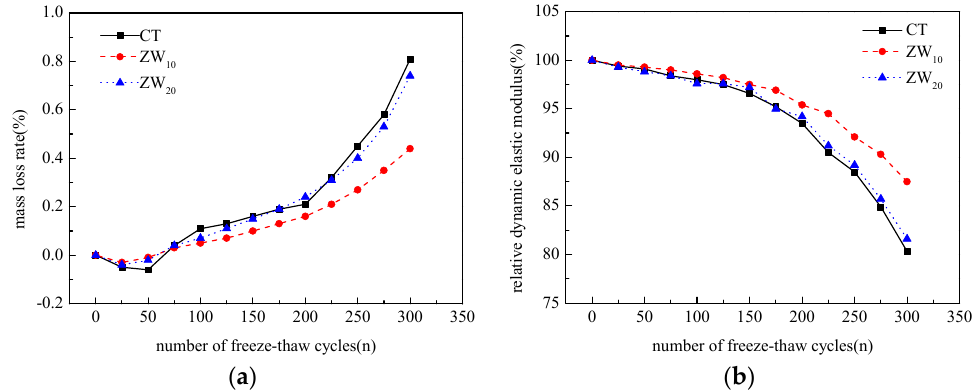
Figure 8. ( a ) Mass loss rate and ( b ) relative dynamic elastic modulus curve of different content of CANCP with the number of freeze–thaw cycles.